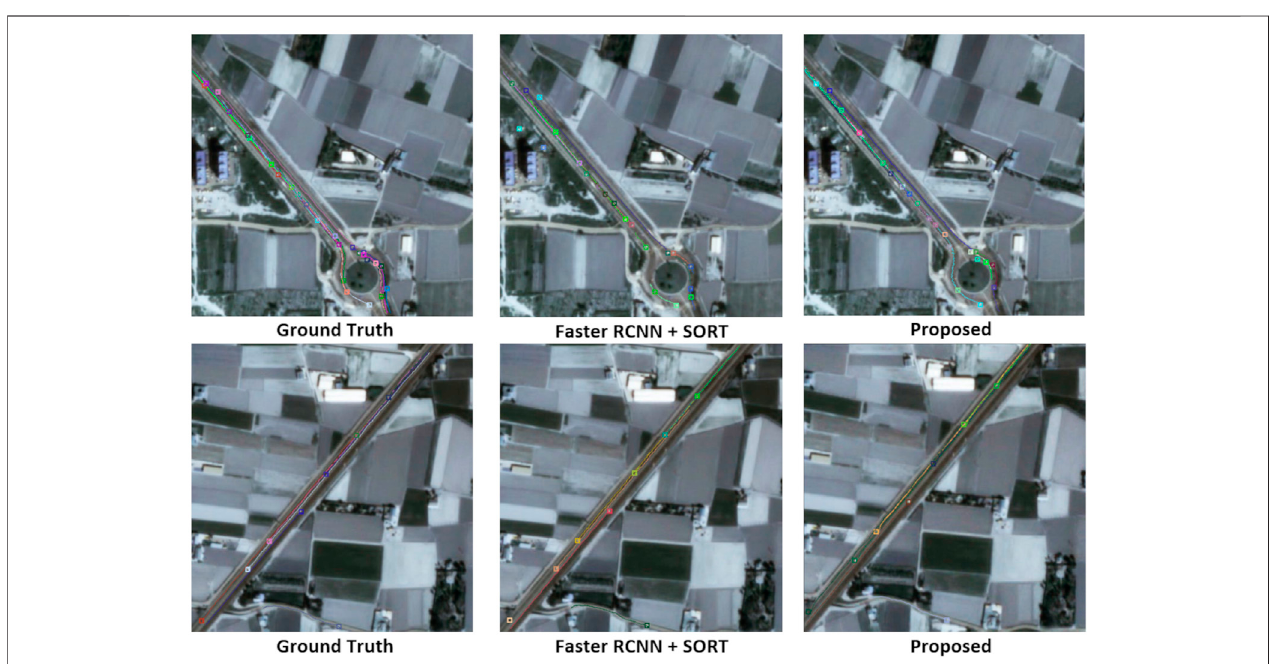
FIGURE 8 | Sample Object Tracking. The square denotes the object current location and the line the object past locations. First column: ground truth marks. Second Column: Faster RCNN (Ren et al., 2015) and SORT (Bewley et al., 2016). Third column: proposed tracking algorithm.